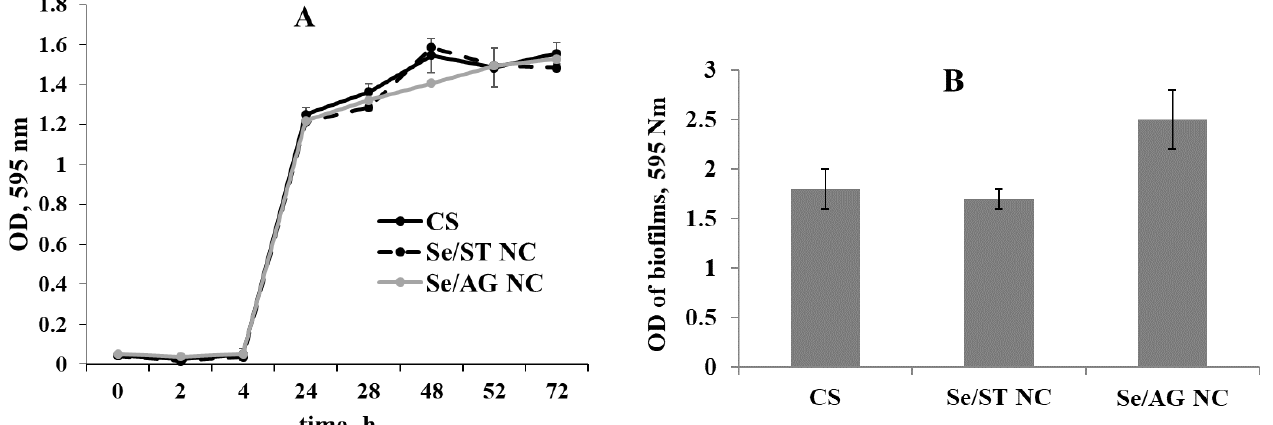
Figure 7. Effect of the Se NC treatments on growth ( A ) and biofilm formation ( B ) of Rhodococcus erythropolis . OD—optical density.